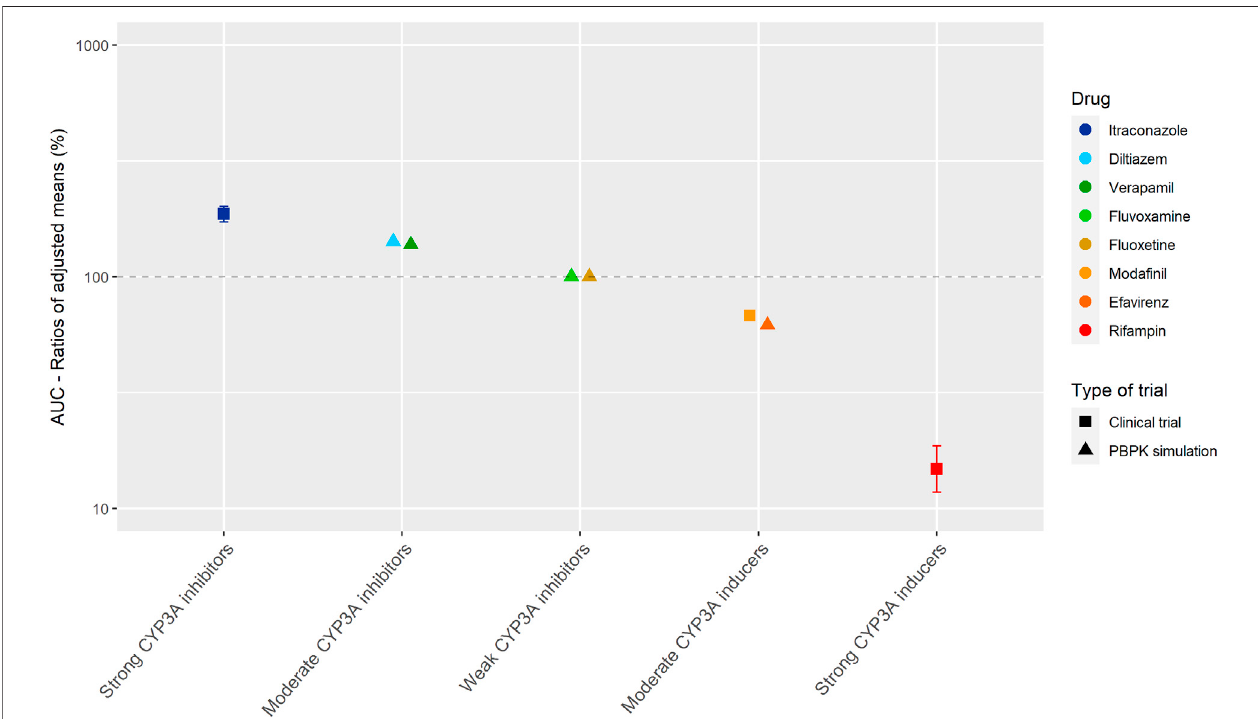
FIGURE3 | Overview of theresults from DDI studies ofpalbociclib combined with CYP3Ainhibitorsand inducers. The coloured symbols represent the increase or decreaseinAUCcausedbytheinteractingdrug,expressedasadjustedmean ± 90%con fi denceinterval(ifavailable).ThedashedlinerepresentsthebaselineAUC(Food and Drug Administration, 2014d; European Medicines Agency Committee for Medicinal Products For Human Use (CHMP), 2016b; Yu et al., 2017).